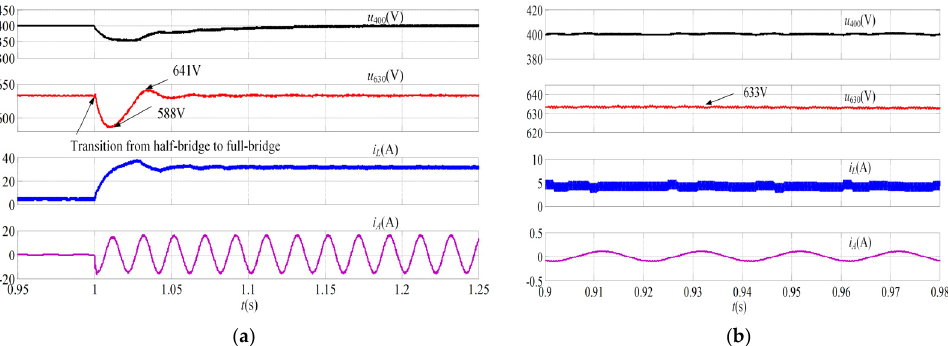
Figure 14. Simulation results in off-line mode: ( a ) transition waveforms; and ( b ) steady state waveforms with light load.